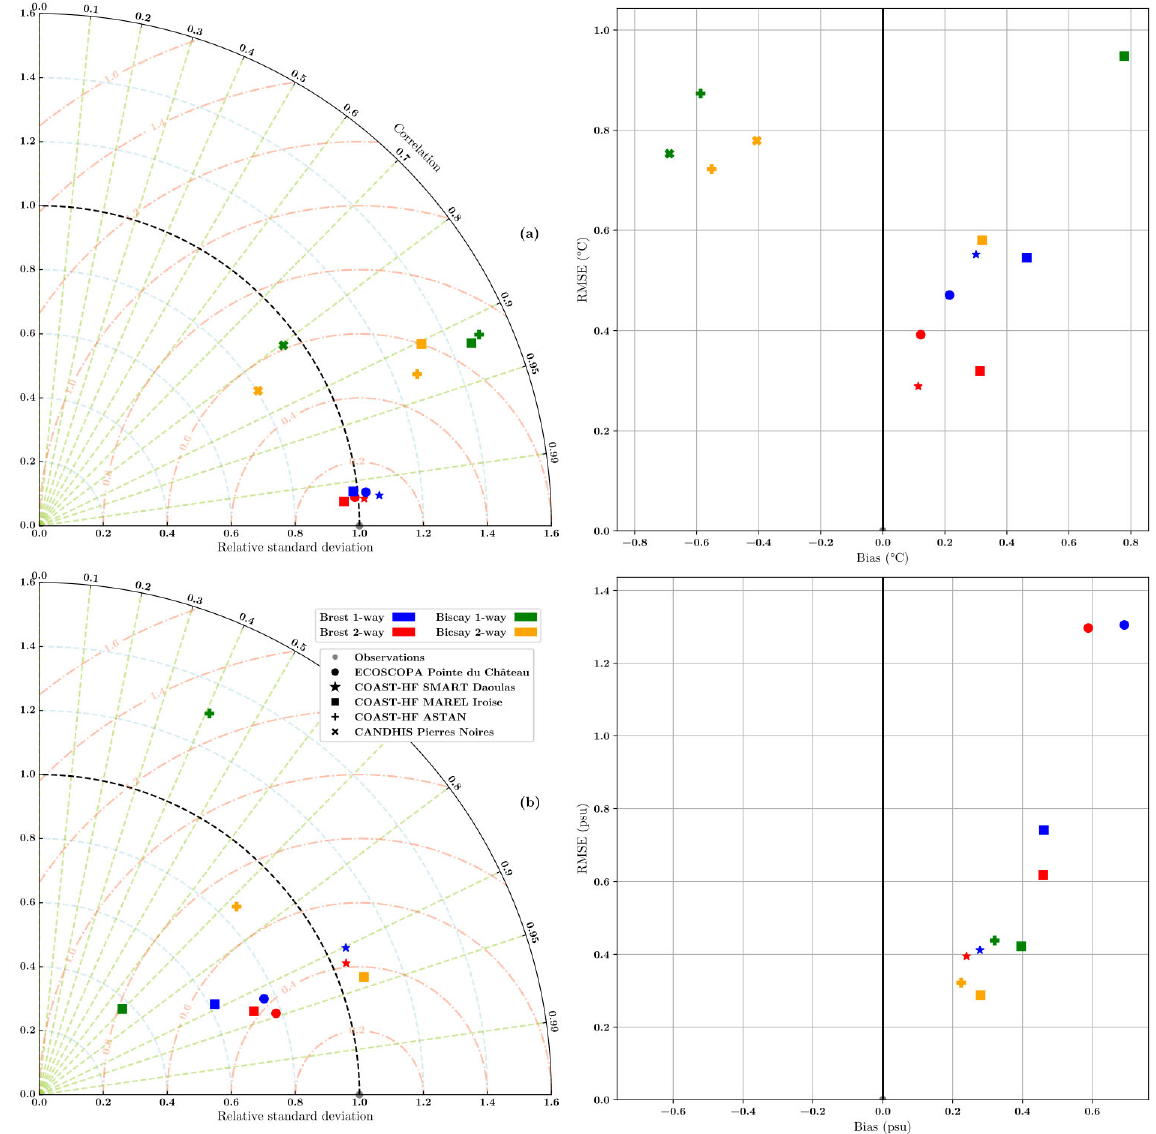
Figure 6. Temperature (a) and salinity (b) validation for both configurations. The Taylor diagrams are represented with the relative standard deviation (dashed blue lines), correlation (dashed green lines) and relative root mean square error (dashed red